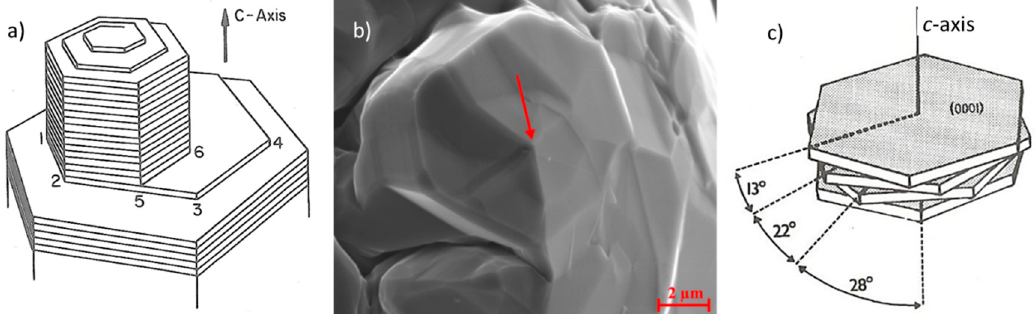
Figure 8. Growth of graphite in the (cid:4670)101(cid:3364)0(cid:4671) direction: ( a ) Spiral growth by screw dislocation reproduced from [32]; ( b ) spiral growth in graphite from Ni-C alloy, reproduced from [33] with permission from Elsevier; ( c ) growth from the step at twist boundary, reproduced from [34].